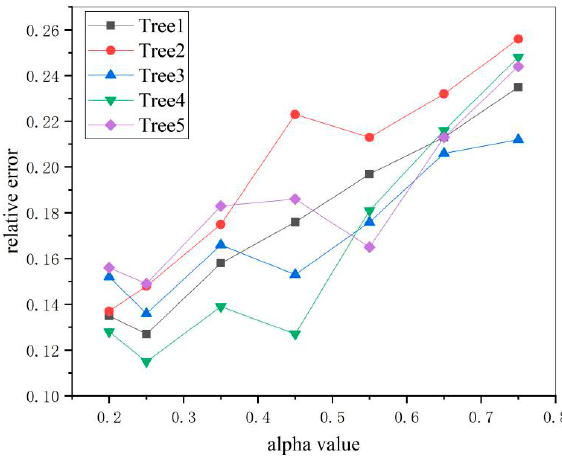
Figure 9. Canopy volume measurement results under different alpha values.